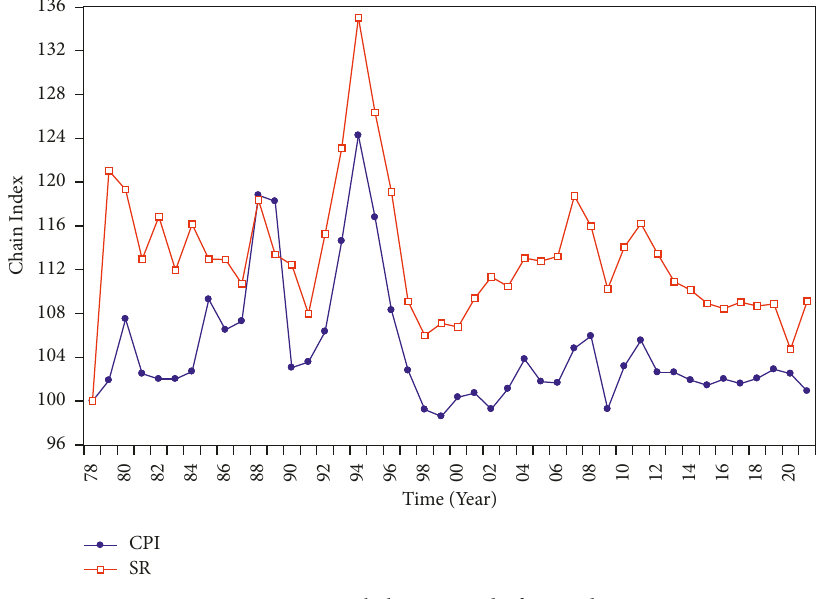
Figure 1: Sequential change trend of SR and